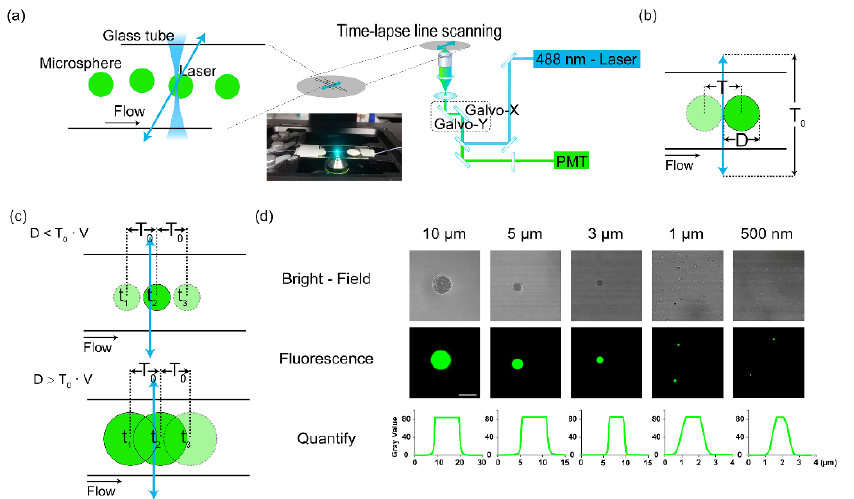
Figure 1. The scheme of line scanning by a confocal microscope for cytometry. ( a ) The setup of the line scanning method to detect flowing samples. The scanning line was defined transversely across the flow. The fluidic system used a peristaltic pump to pump suspensions of microbeads to a capillary tube (100 µm in diameter) that was put on a glass slide on the microscope stage. Arrow line: the laser scanning. ( b ) The scanning line transversely across the fluidic flow. D: diameter of the passing particles. T 0 : time of a single-time scanning period of the laser. ( c ) The sampling frequency was determined by the fluidic velocity (v). Upper panel: the case of less sampling: D < v · T 0 ; lower panel: D > v · T 0 . ( d ) The quantification of diameter of different microbeads by their fluorescence by confocal microscopy. Bar: 10 µm.